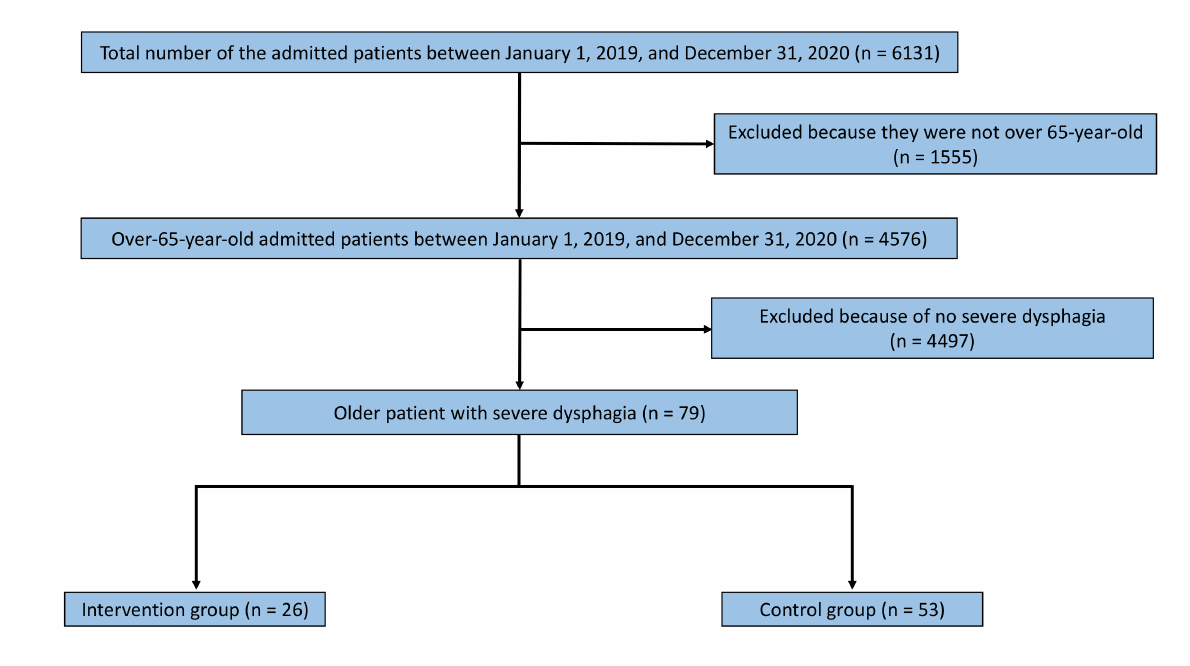
Figure 2. Flow chart of the study